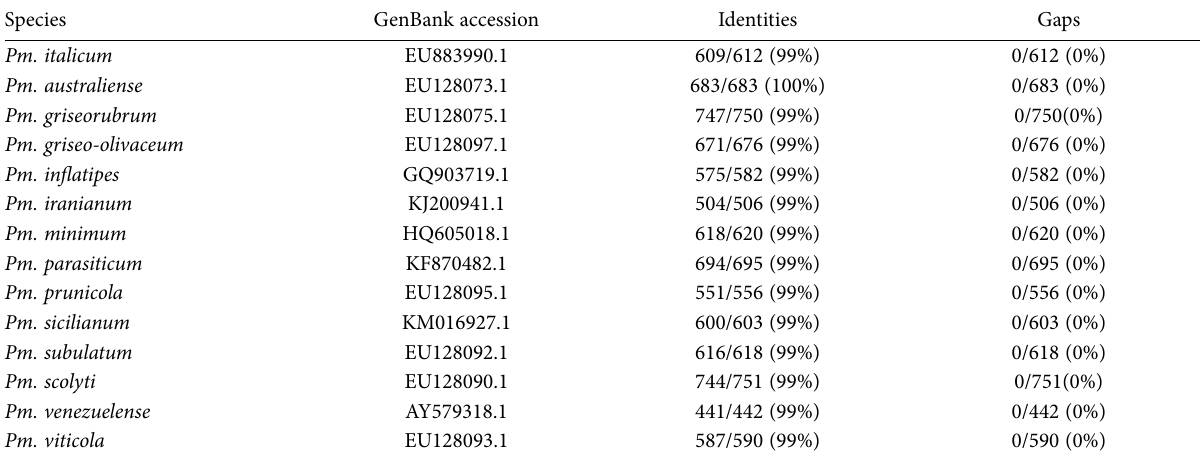
Table 3. Phaeoacremonium species identification with the partial beta-tubulin gene using the megablast search of GenBank.